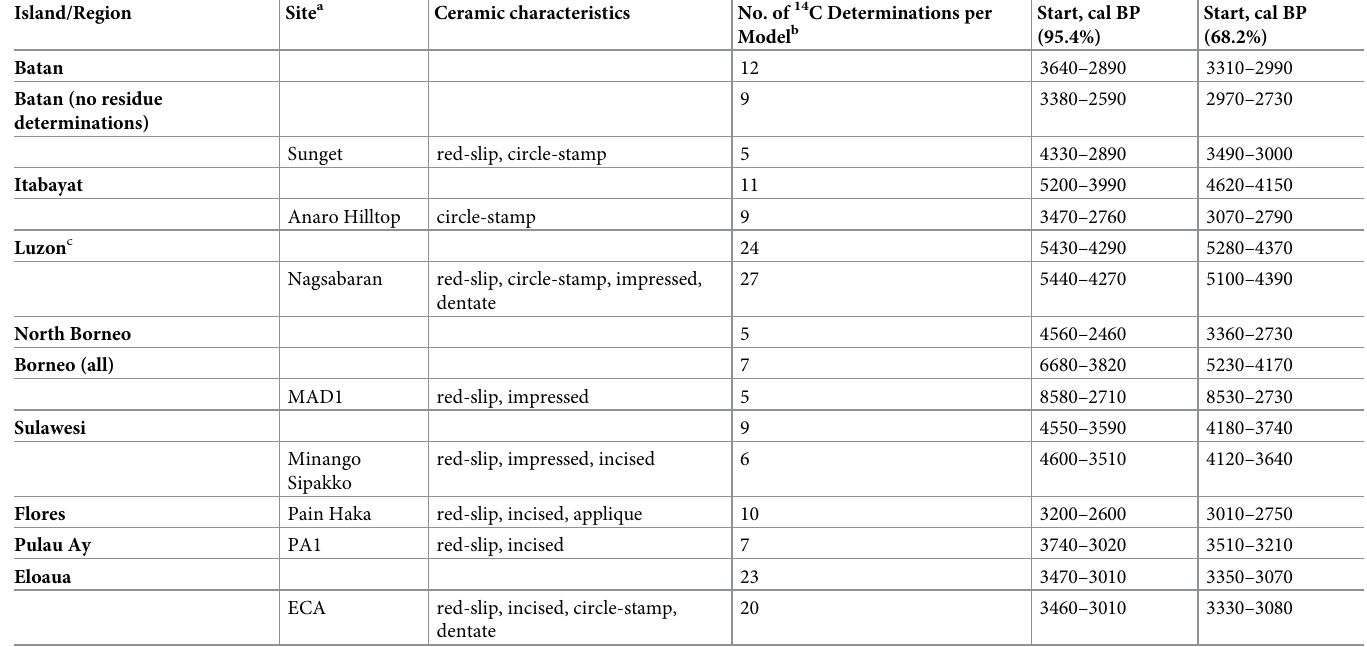
Table 1. Modeled